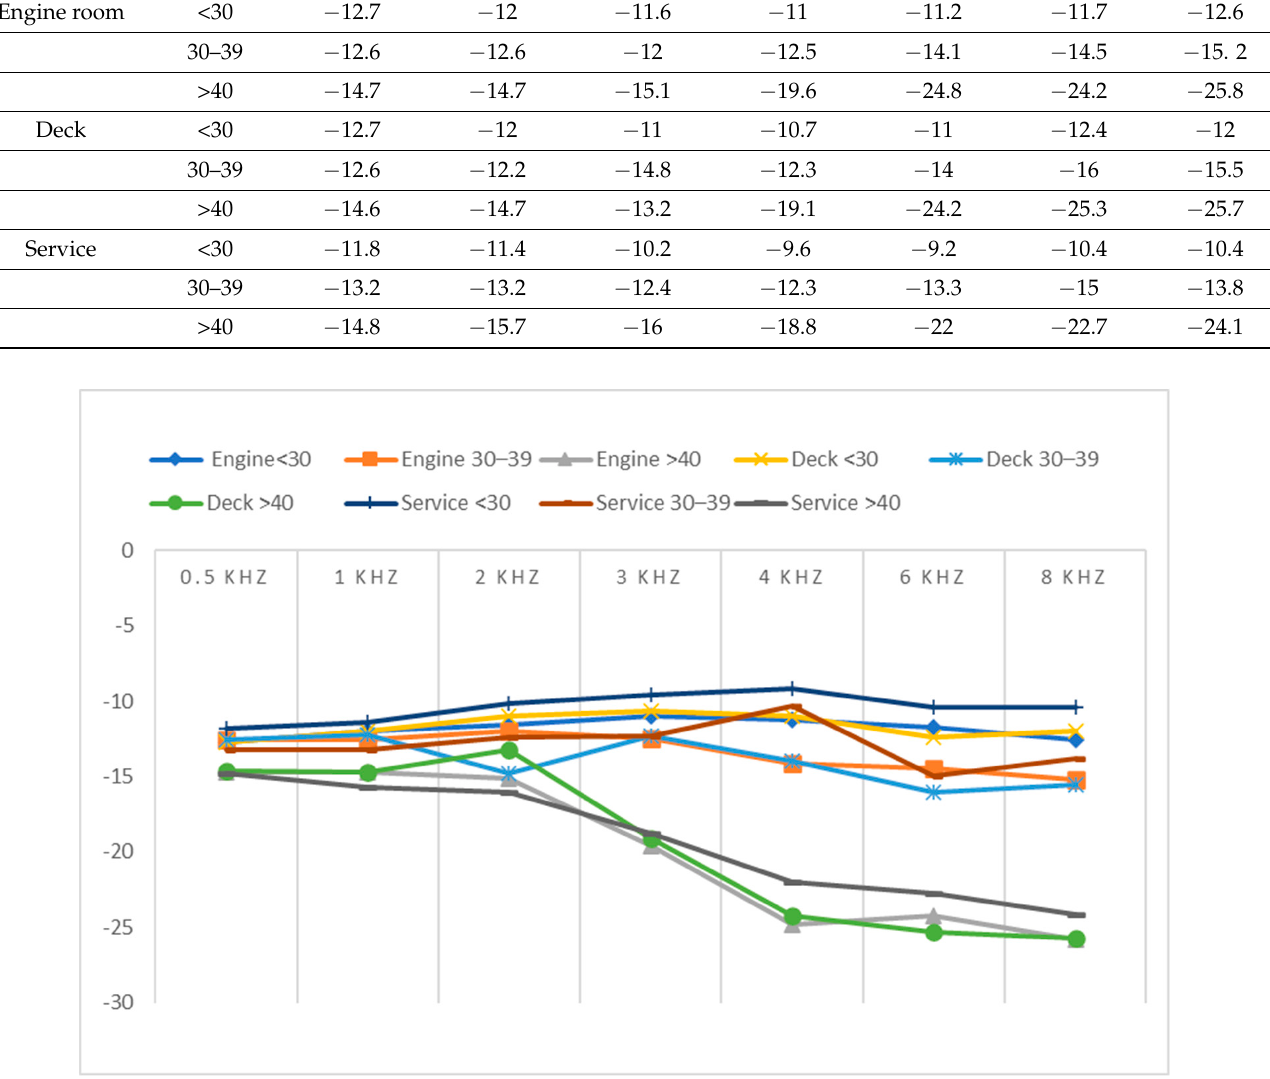
Figure 1. Graphic of mean hearing threshold levels in the sample of merchant seafarers, in each frequency tested .